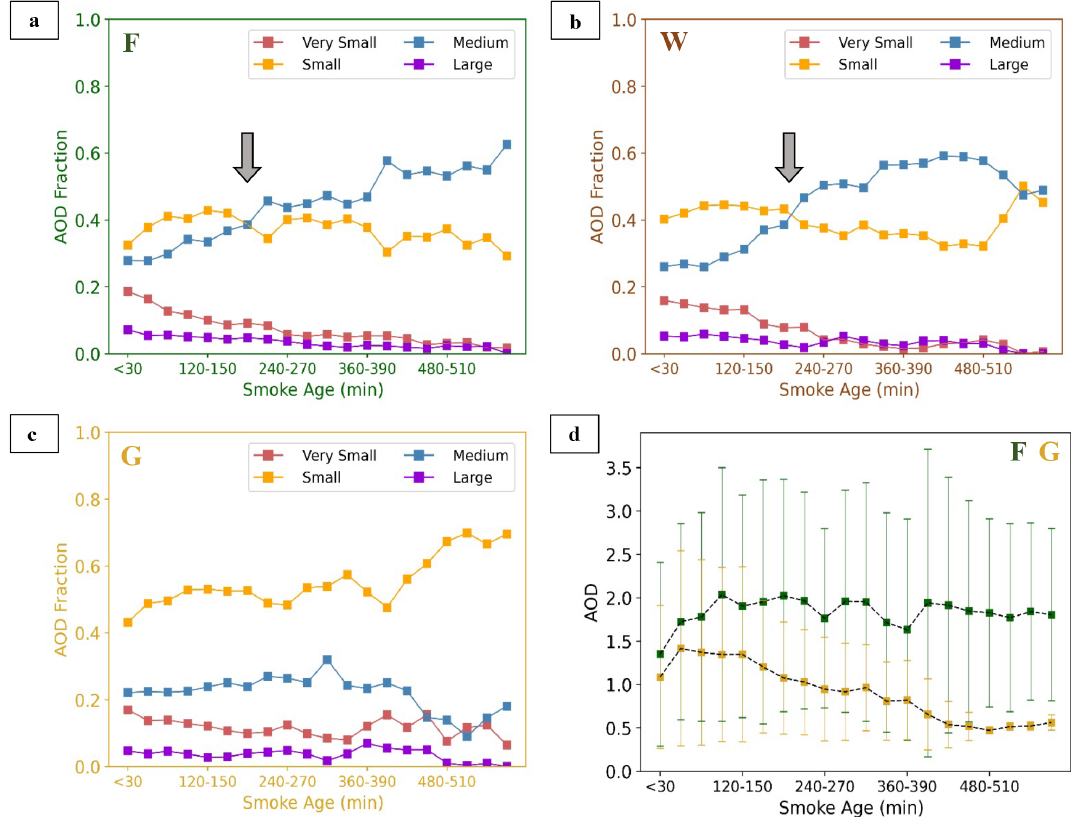
Figure 5. MISR particle-size component AOD fractions (in terms of the contribution to the total AOD, from 0 to 1) by smoke age for (a) Forest plumes, (b) Woody plumes, and (c) Grassy plumes. In panel (d) , the MISR mid-visible AOD is plotted by age for forest and grassy plumes, for reference. The points represent the mean values, and the whiskers are standard deviations. Arrows help highlight the points of important particle-size